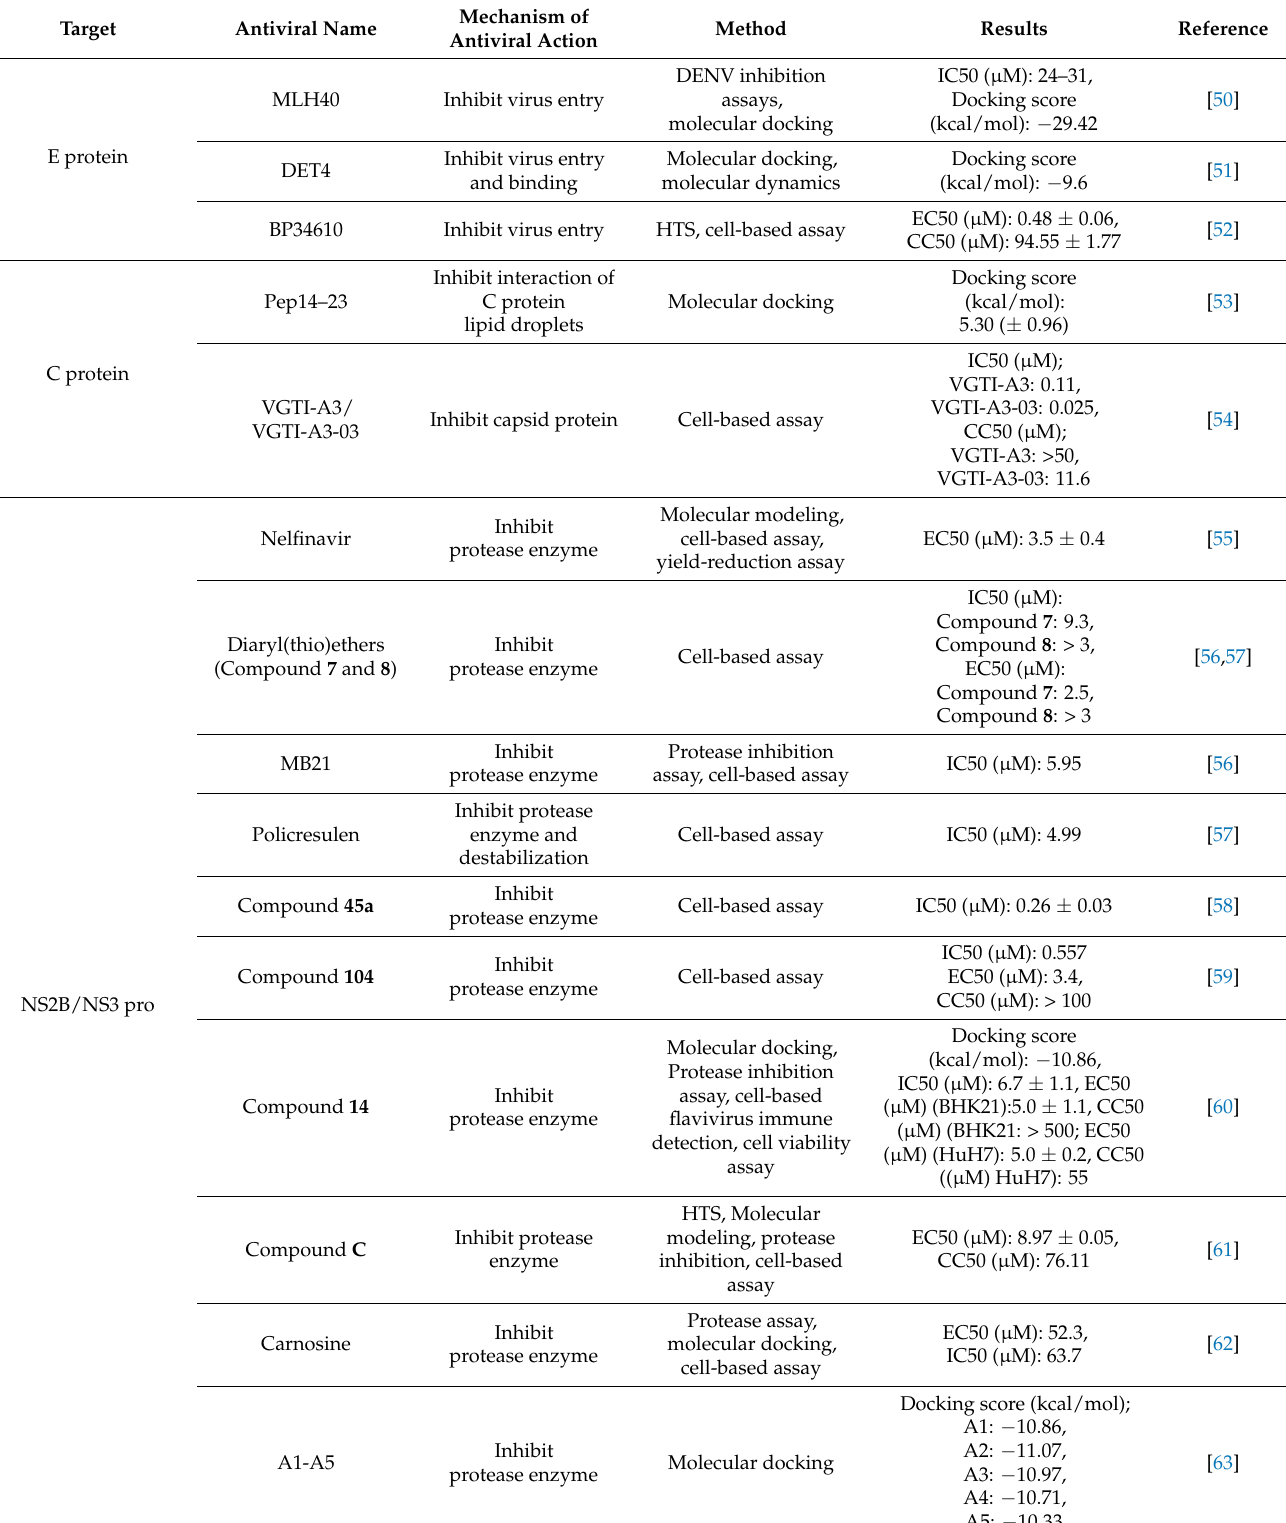
Table 2. Summary of dengue potent inhibitors based on their